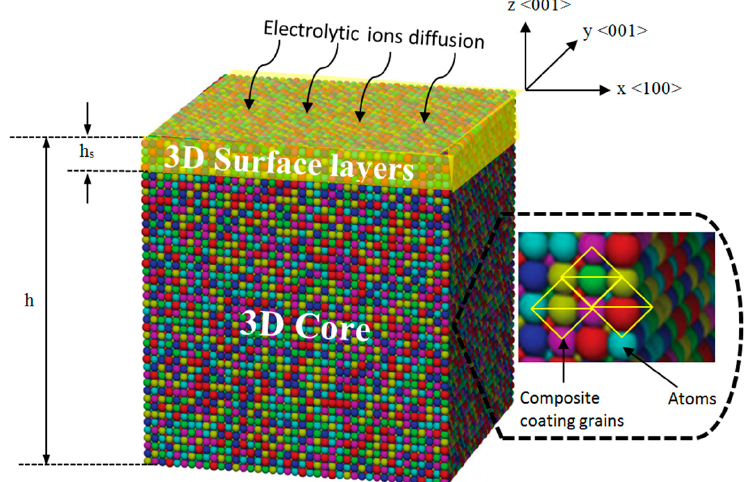
Figure 5. A 3D model of nanocomposite coating separated into a 3D surface layer with the thickness h s coherently adhered to the 3D core with the thickness h − h s . coherently adhered to the 3D core with the thickness h − h s